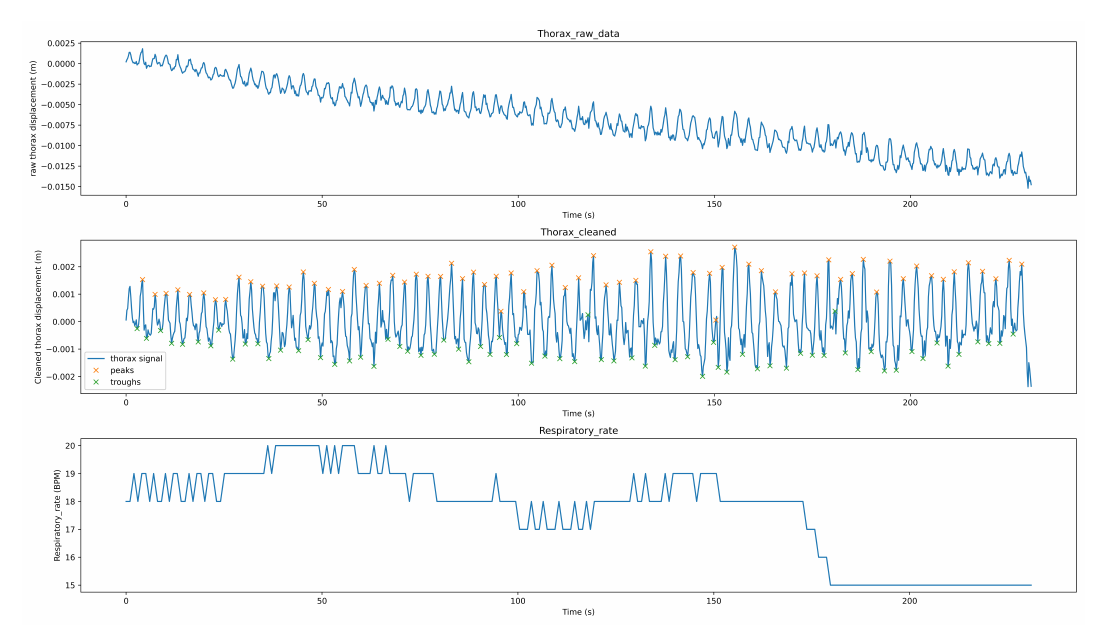
Figure 10. Breathing analysis for a beginner meditator.